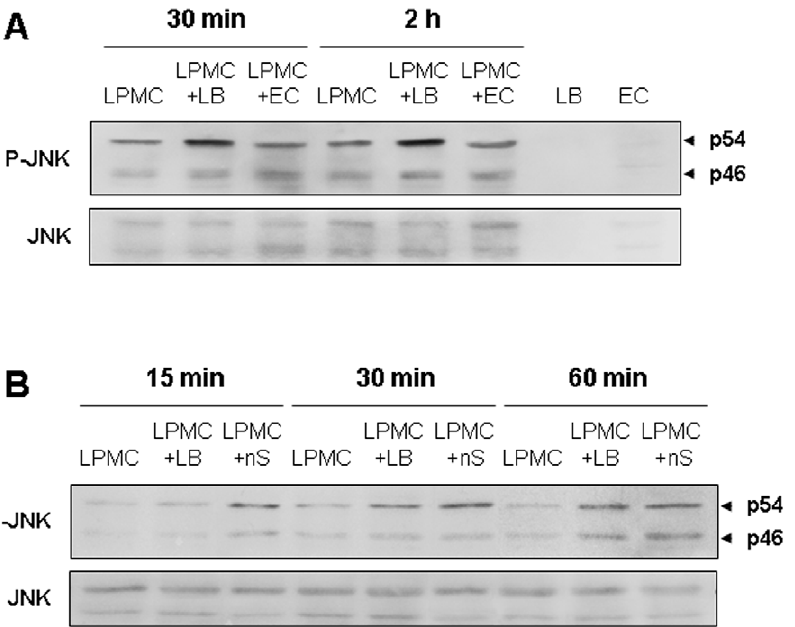
Figure 5. L.brevis -induced JNK phosphorylation by LPMC. A) L. brevis - but not E.coli -induced phosphorylation of JNK in LPMC. Control LPMC were left alone or exposed to L. brevis or E. coli sonicates for 30 minutes or 2 hours, after which JNK phosphorylation was assessed. JNK is not detected in L. brevis or E. coli sonicates (two last lanes on the right). B) Exogenous nSMAse-induced phosphorylation of JNK in LPMC. Control LPMC were left alone or exposed to L. brevis or recombinant neutral SMAse for 15, 30 or 60 minutes, after which JNK phosphorylation was assessed. LB= L. brevis sonicates; EC= E. coli sonicates; nS=nSNAse. Figure is representative of 3 separate experiments.